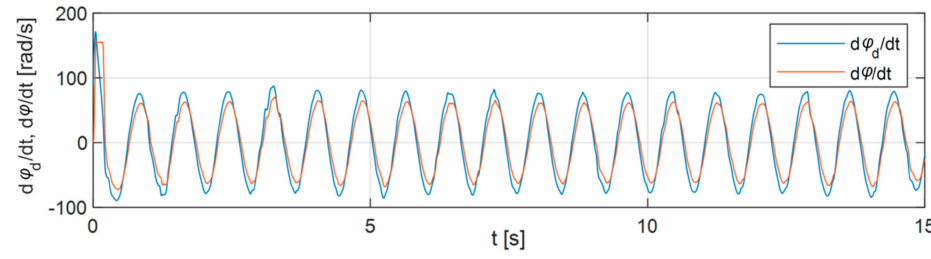
Figure 18. Set d ϕ d / dt and realized d ϕ / dt angular speeds of the active part as functions of time.